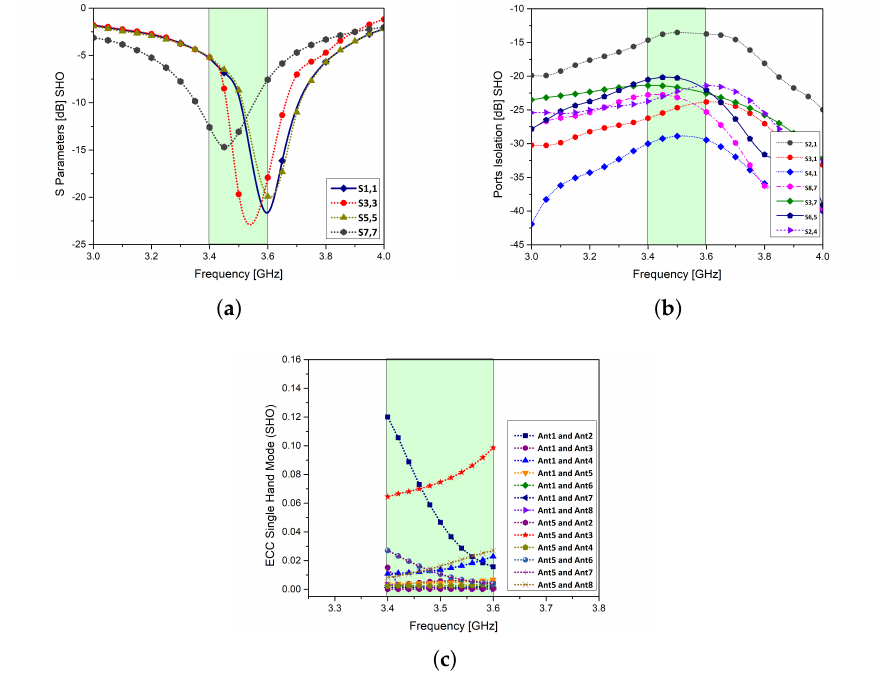
Figure 11. Performance parameters in single hand mode (SHM): ( a ): S-parameters, ( b ): port isolation, ( c ):